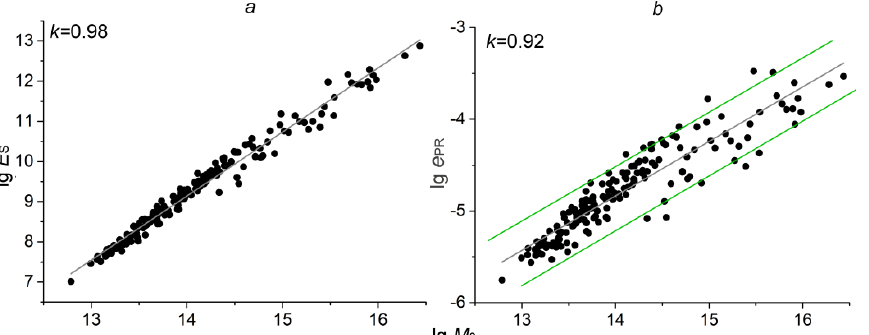
Fig. 8. Distribution of seismic (a) and reduced seismic energy (b) versus seismic moment on a double logarithmic